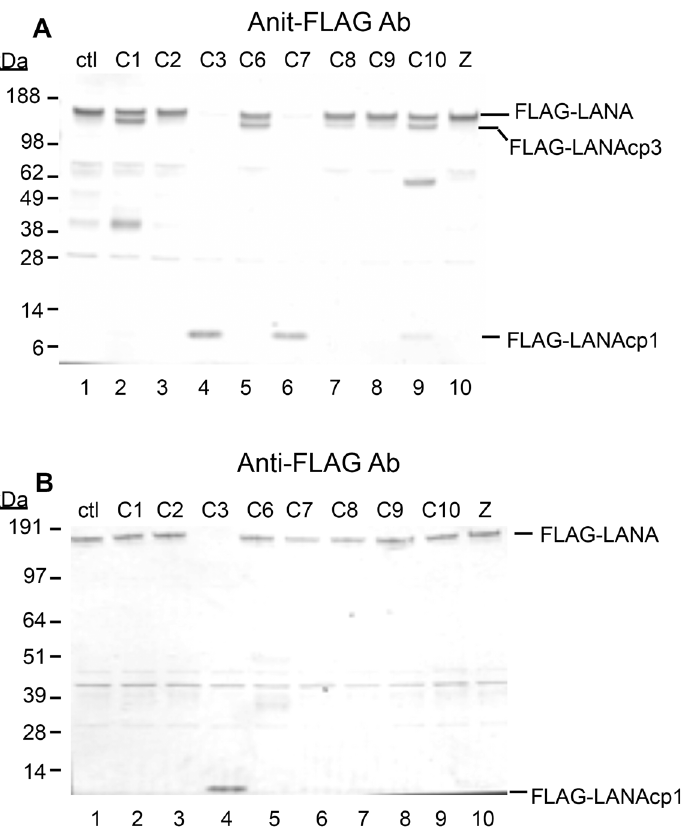
N-terminus as stated in Materials and Methods. Nuclear extracts containing LANA were harvested in the absence of protease inhibitors, treated with caspases for 16 hrs at 37°C and then analyzed by western